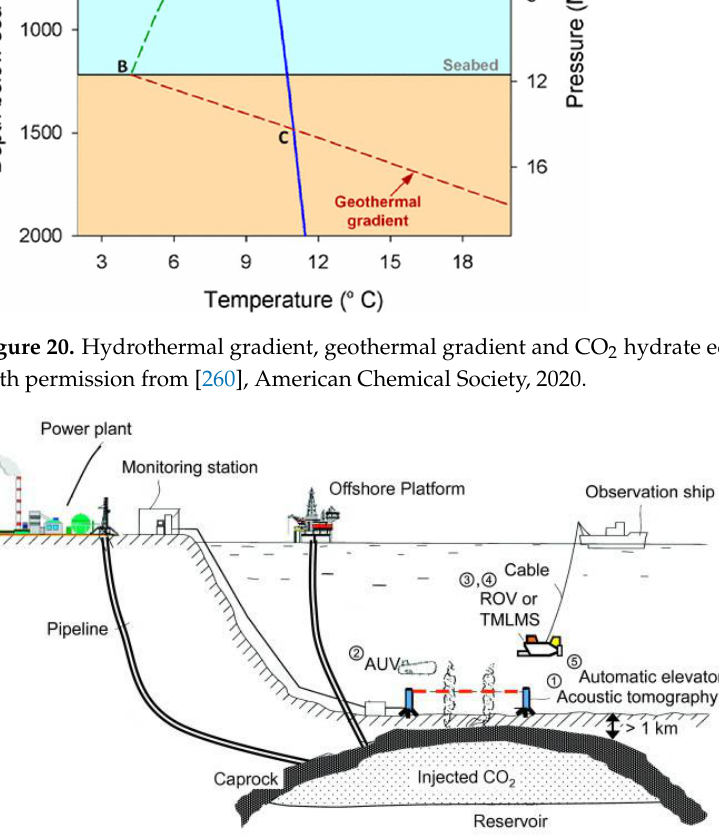
Figure 21. Strategy for detection and monitoring of CO 2 leakage in sub-seabed CCS. Reproduced with permission from [265], Elsevier, 2013.